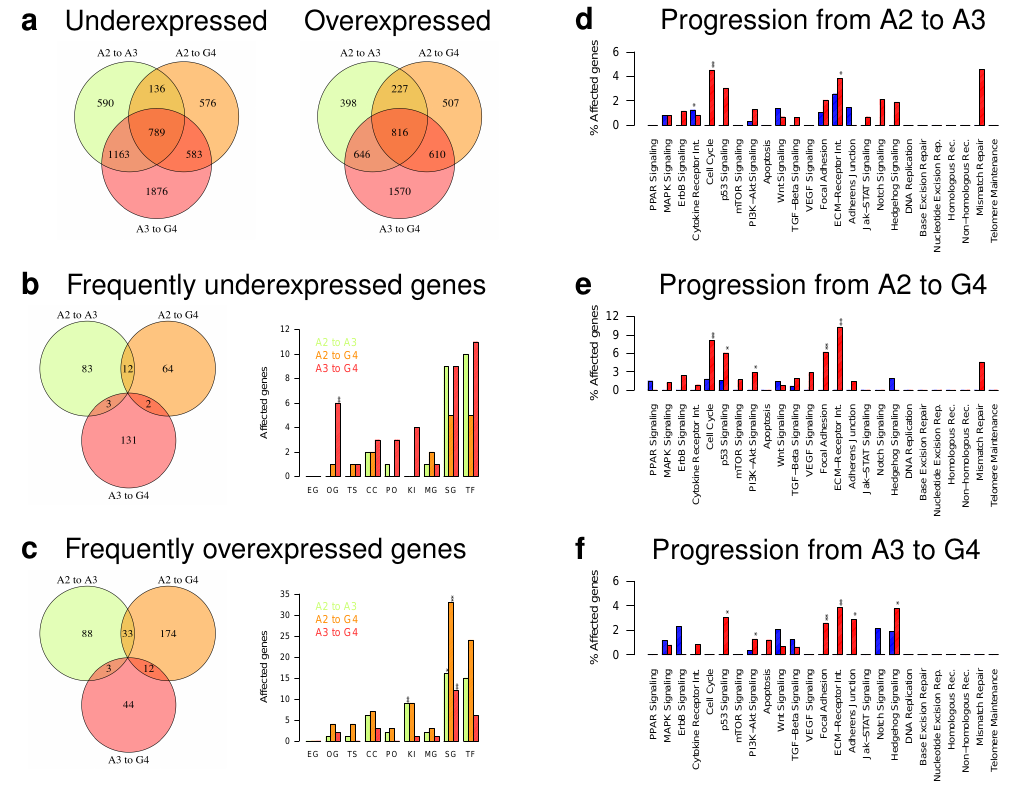
Figure 5. Differentially expressed genes and signaling pathway alterations distinguishing astrocytoma progression groups. Differentially expressed signaling and metabolic pathway genes were determined for each patient-matched astrocytoma pair in each of the three progression groups (A2 to A3, A2 to G4, A3 to G4). ( a ) Venn diagrams of under- and overexpressed genes observed in at least one patient-matched tumor pair; ( b , c ) Venn diagrams and bar plots of functional annotations of under—( b ) and overexpressed ( c ) genes observed in at least 50% of patient-matched pairs of a progression